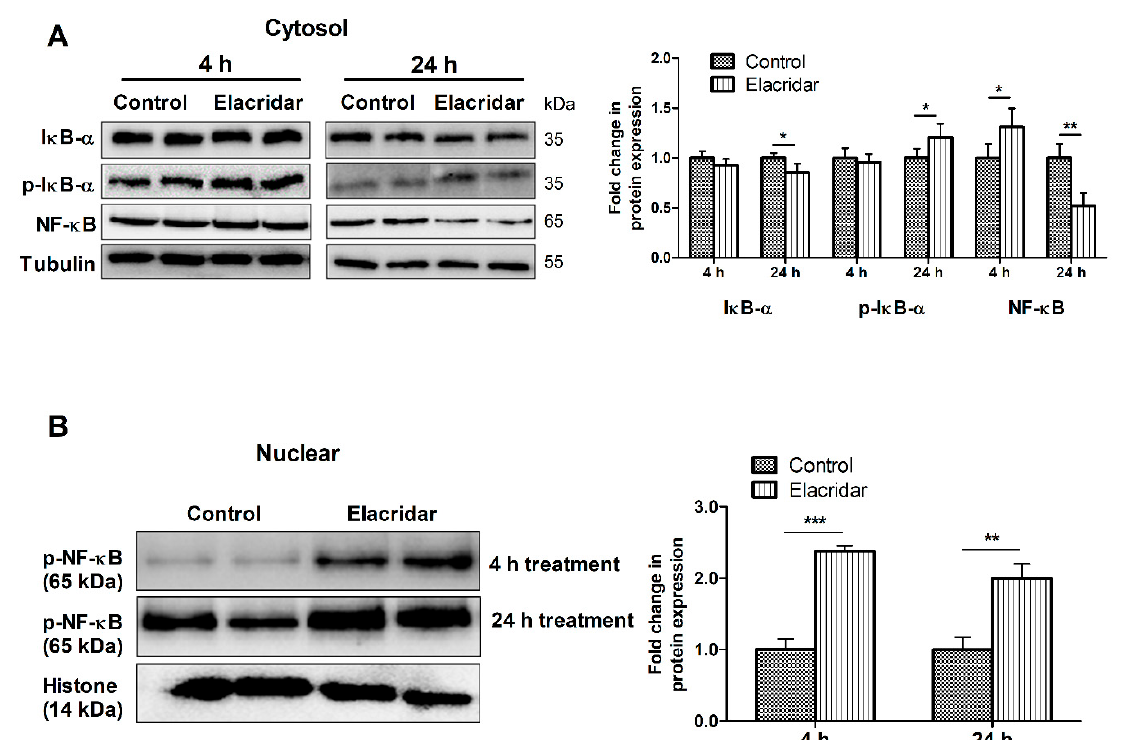
Figure 2. Treatment with elacridar (5 µ M) significantly activated the NF- κ B pathway in cultured bEnd3 cells in vitro. ( A ) Representative Western blot and densitometry analysis of the cytosolic fraction of I κ B- α , p-I κ B- α , and NF- κ B, presented as fold change by elacridar compared to vehicle treatment, at 4 and 24 h post-treatment. ( B ) Representative Western blot and densitometry analysis of the nuclear fraction of p-NF- κ B, presented as fold change by elacridar compared to vehicle treatment, at 4 and 24 h post-treatment. Statistical analysis was determined by Student’s t -test. Data are presented as mean ± SD of 3 independent experiments. * p < 0.05, ** p < 0.01, *** p < 0.001 compared to control. kDa indicates the molecular weight of analyzed proteins.